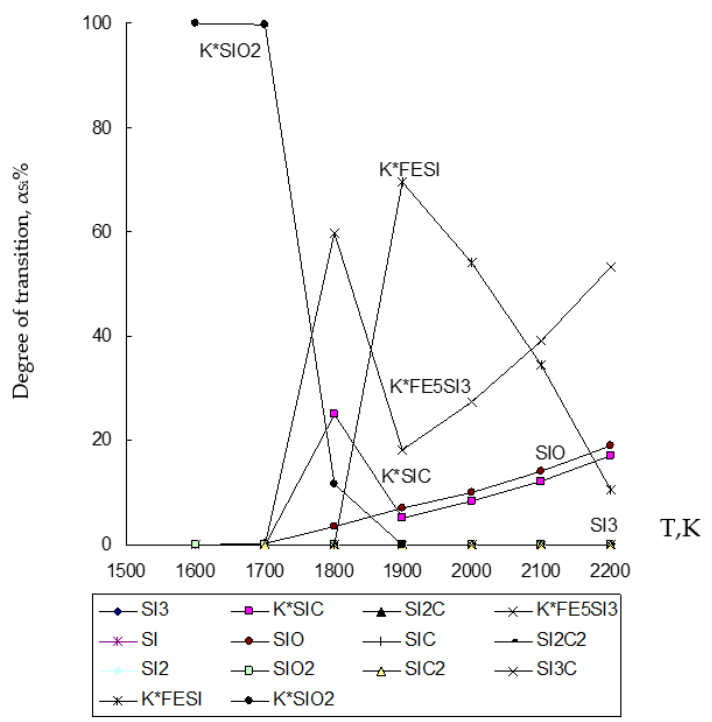
Figure 4. Influence of temperature (T) on the degree of distribution (α) of Si in the ZnO∙SiO 2 - FeO∙Fe 2 O 3 -C system.